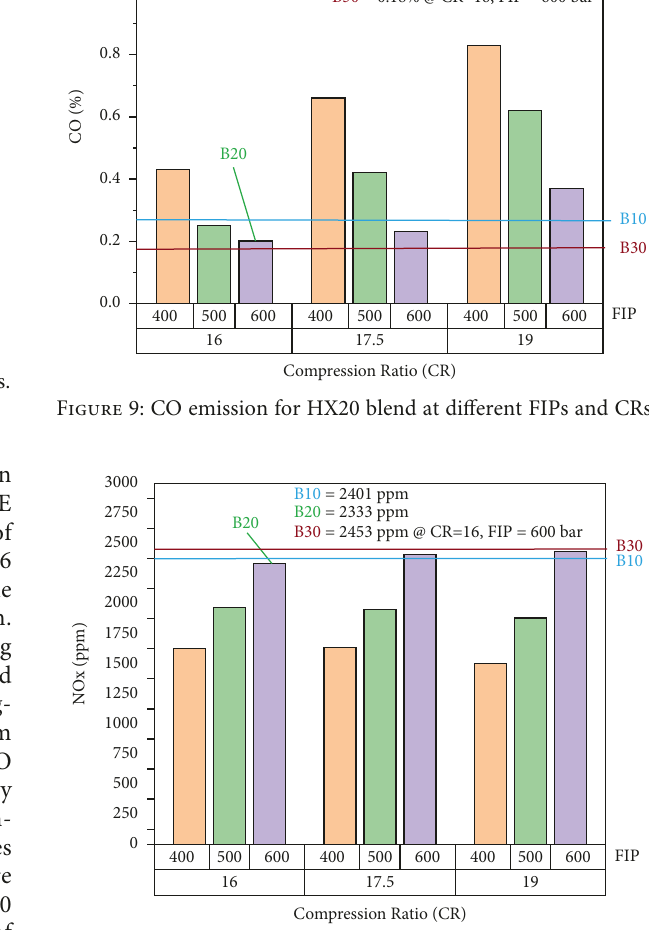
Figure 10: NOx emission for B20 blend at various FIPs and CRs.